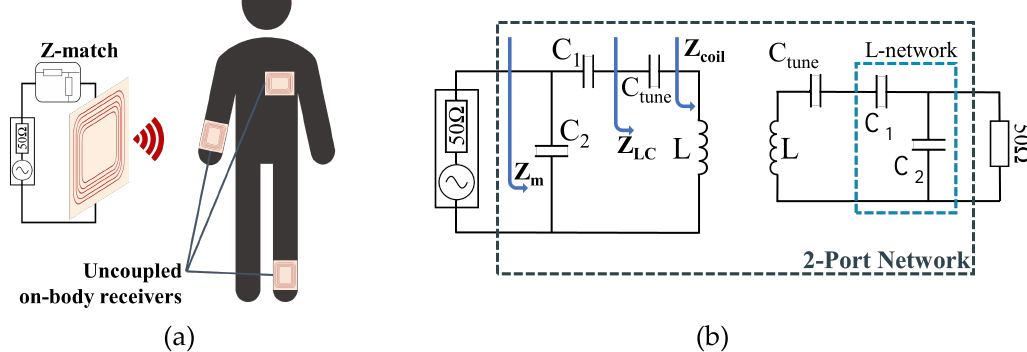
Figure 3. The proposed uncoupled radiative WPT: ( a ) system architecture, ( b ) 2-coil system schematic and impedance matching